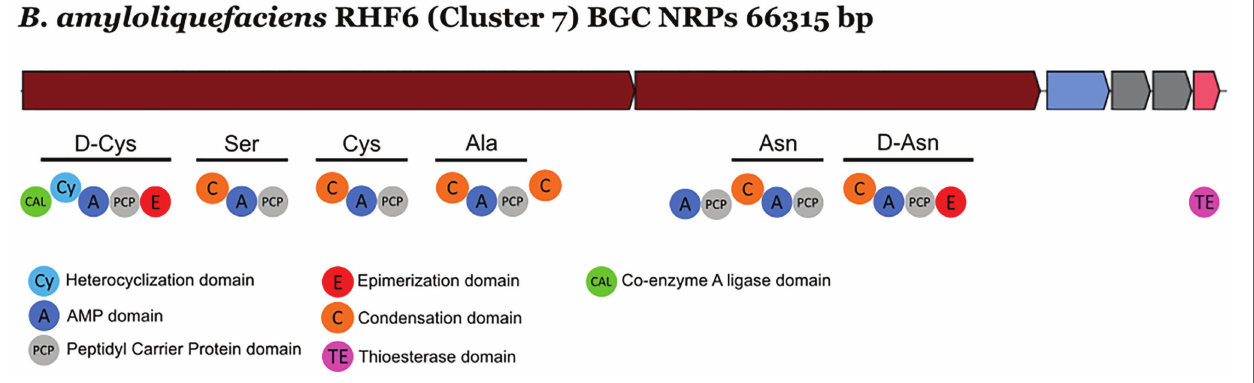
FIGURE 6 | Novel NRP Biosynthetic gene Clusters identified from the isolate Bacillus amyloliquefaciens